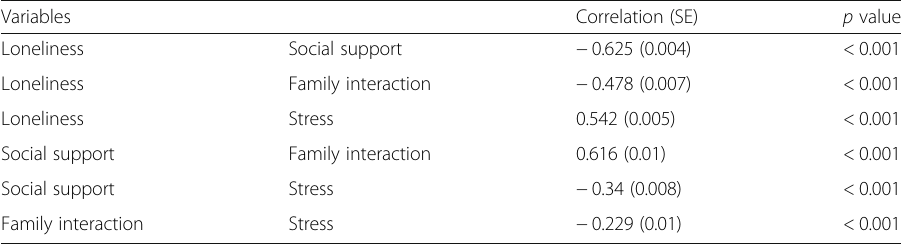
Table 3 Correlations among latent variables